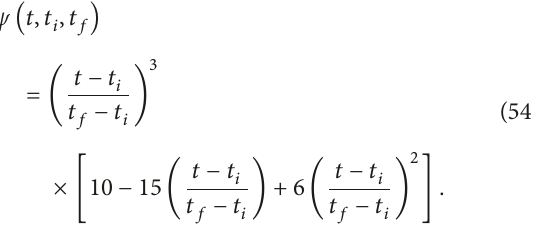
Table 3: Abrupt changes in 𝐸 𝑟 and 𝐸 𝑙 .